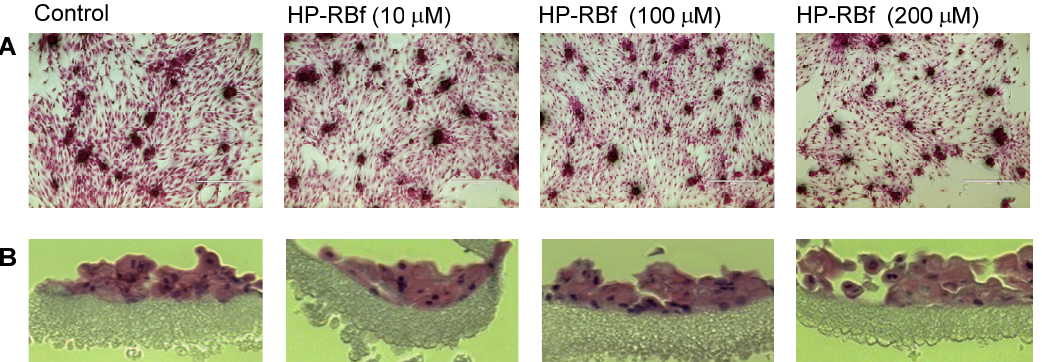
Figure 7. Integrity of multi-layered human epidermal keratinocytes (HEKa) cells by treatment of HP-RBf under the fluorescent light. The cells were grown (25 days) using the Nunc Cell Culture Insert system (CLS-AN-047W) [67]. HEKa cells were treated with HP-RBf (10–200 µ M) in the fluorescent light for 1 h (17 W, 63.8 cm 2 , 0.96 KJ/cm 2 ). Stained with hematoxylin and eosin; ( A ) top view ( × 10) ( B ) side view ( ×